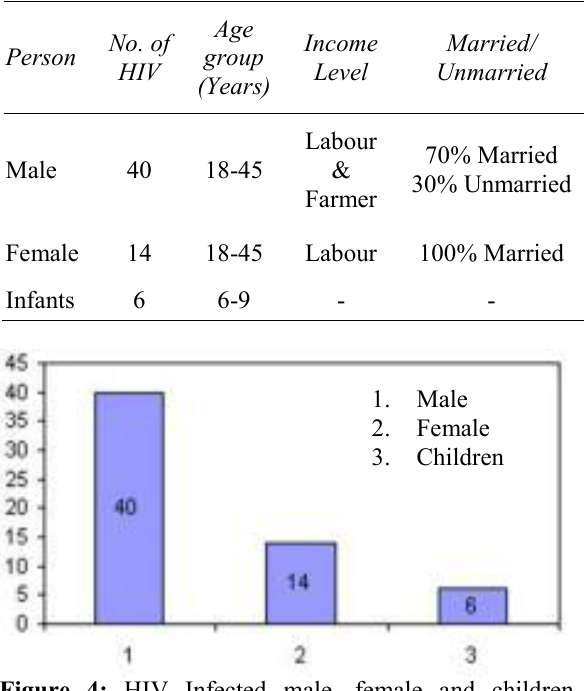
Table 2: Statistics of HIV Spread in Rural Area